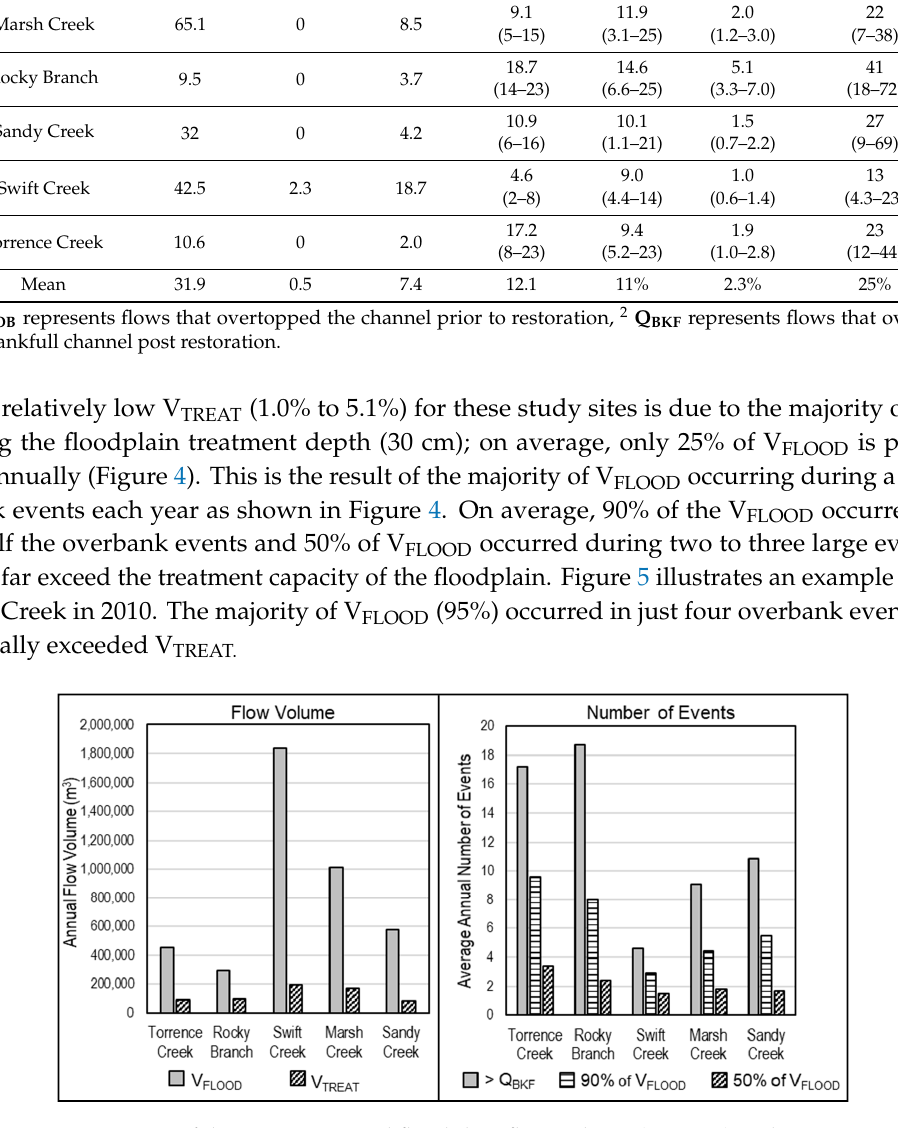
Figure 5. Cumulative and event volume for Torrence Creek in 2010. The maximum discharge for each event is also shown. These results support previous research [12,13,21] showing that a few large flood events deliver the majority of the annual floodplain flow volume and N load, during which the retention/removal capacity of the floodplain is overwhelmed, and the floodplain acts primarily as a conveyance system. In the future, a trend towards even more overbank flow occurring during only a few storms is likely as intense rainfall events are projected to increase in the southeastern U.S. due to climate change [25]. 3.2. N Retention on the Floodplain The mean TN concentration for each site is included in Table 4. Nitrogen loads delivered to each site in V TREAT ranged from 50 to 180 kg/year (see Table 4); however, with the 20% treatment efficiency applied, the resulting N load retained (L RETAINED ) ranged from 10 to 36 kg/year with an average of 22 kg/year for all five streams. This equates to a TN retention/removal rate of 0.2%–0.4% at each site except Rocky Branch, which retained 1.0%. For most of the sites, this is equivalent to the change in